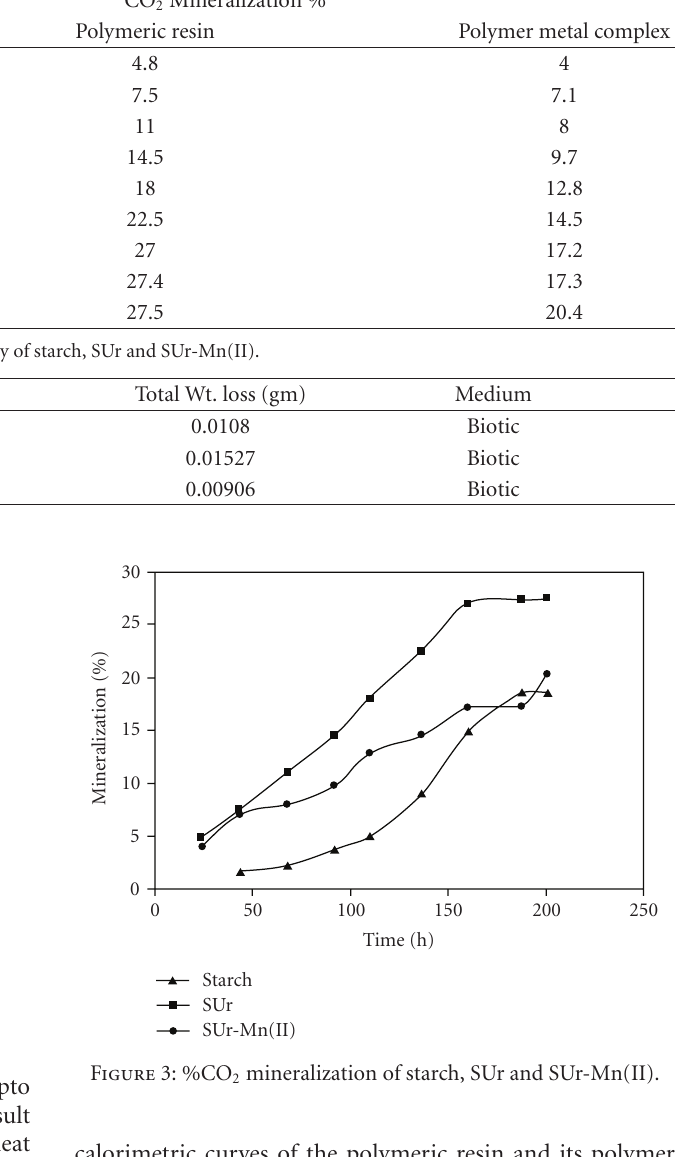
calorimetric curves of the polymeric resin and its polymer metal complexes are reported in Figure 2. The decompo- sition temperature scattered typical range is of 242 ◦ C for polymeric resin and the Tg scattered is in the range of 127 ◦ C for polymeric resin; this evolution could be ascribed due to the interaction between the starch and urea. The